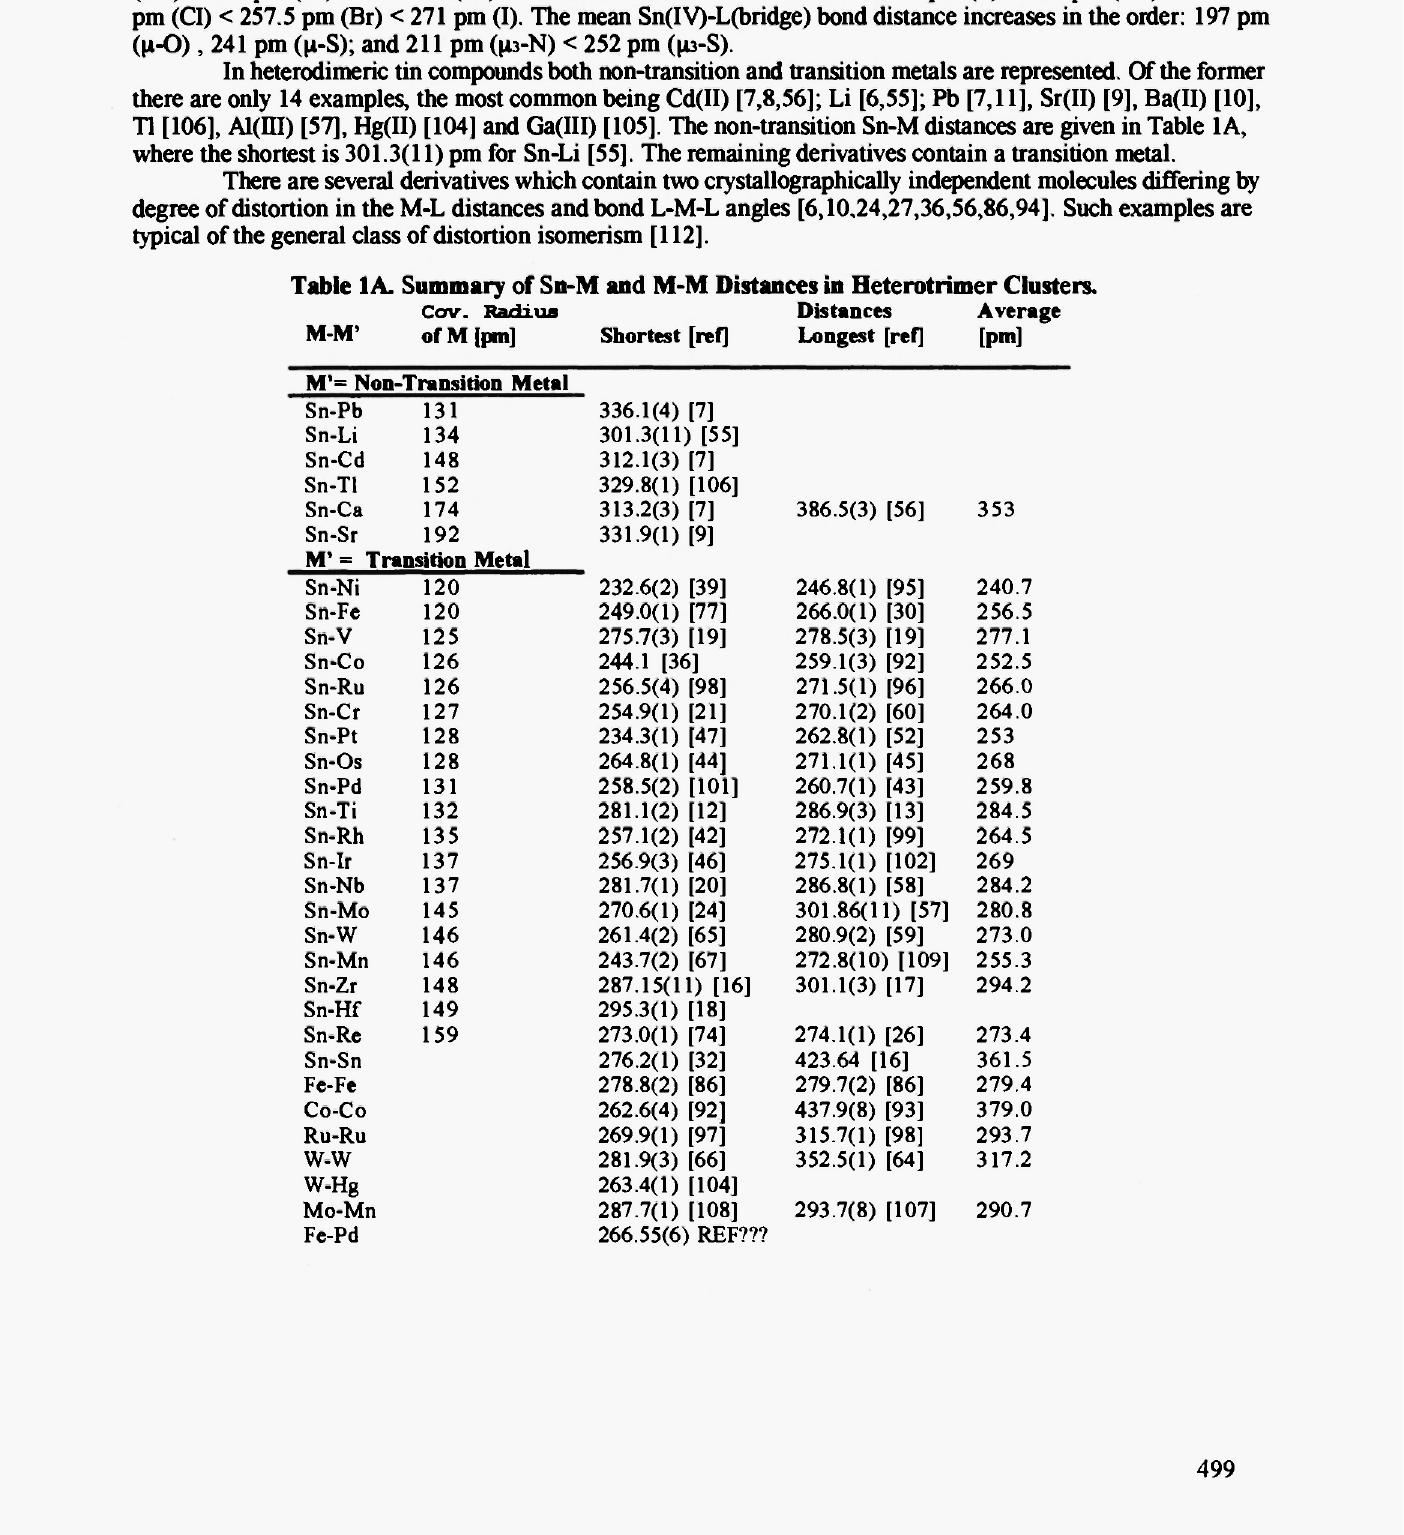
Table 1 A. Summary of Sn-M and M-M Distances in Heterotrimer Clusters. Ccrv.